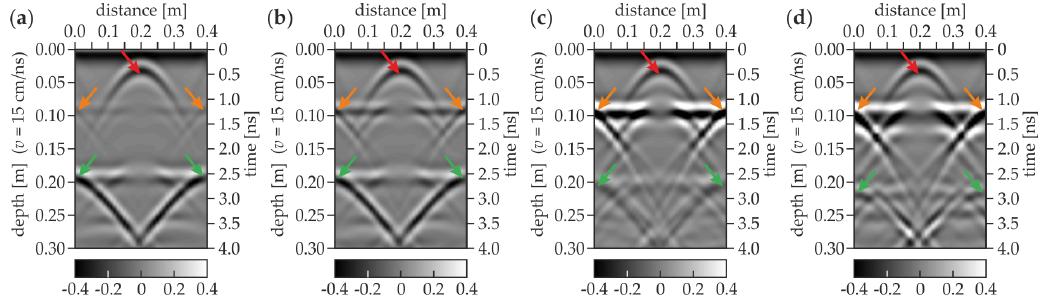
Figure 12. Numerical GPR B ‐ scans for concrete slabs with air gap of thicknesses ( a ) 1 mm (model #2.1); ( b ) 4 mm (model #2.2); ( c ) 20 mm (model #2.3); and ( d ) 50 mm (model